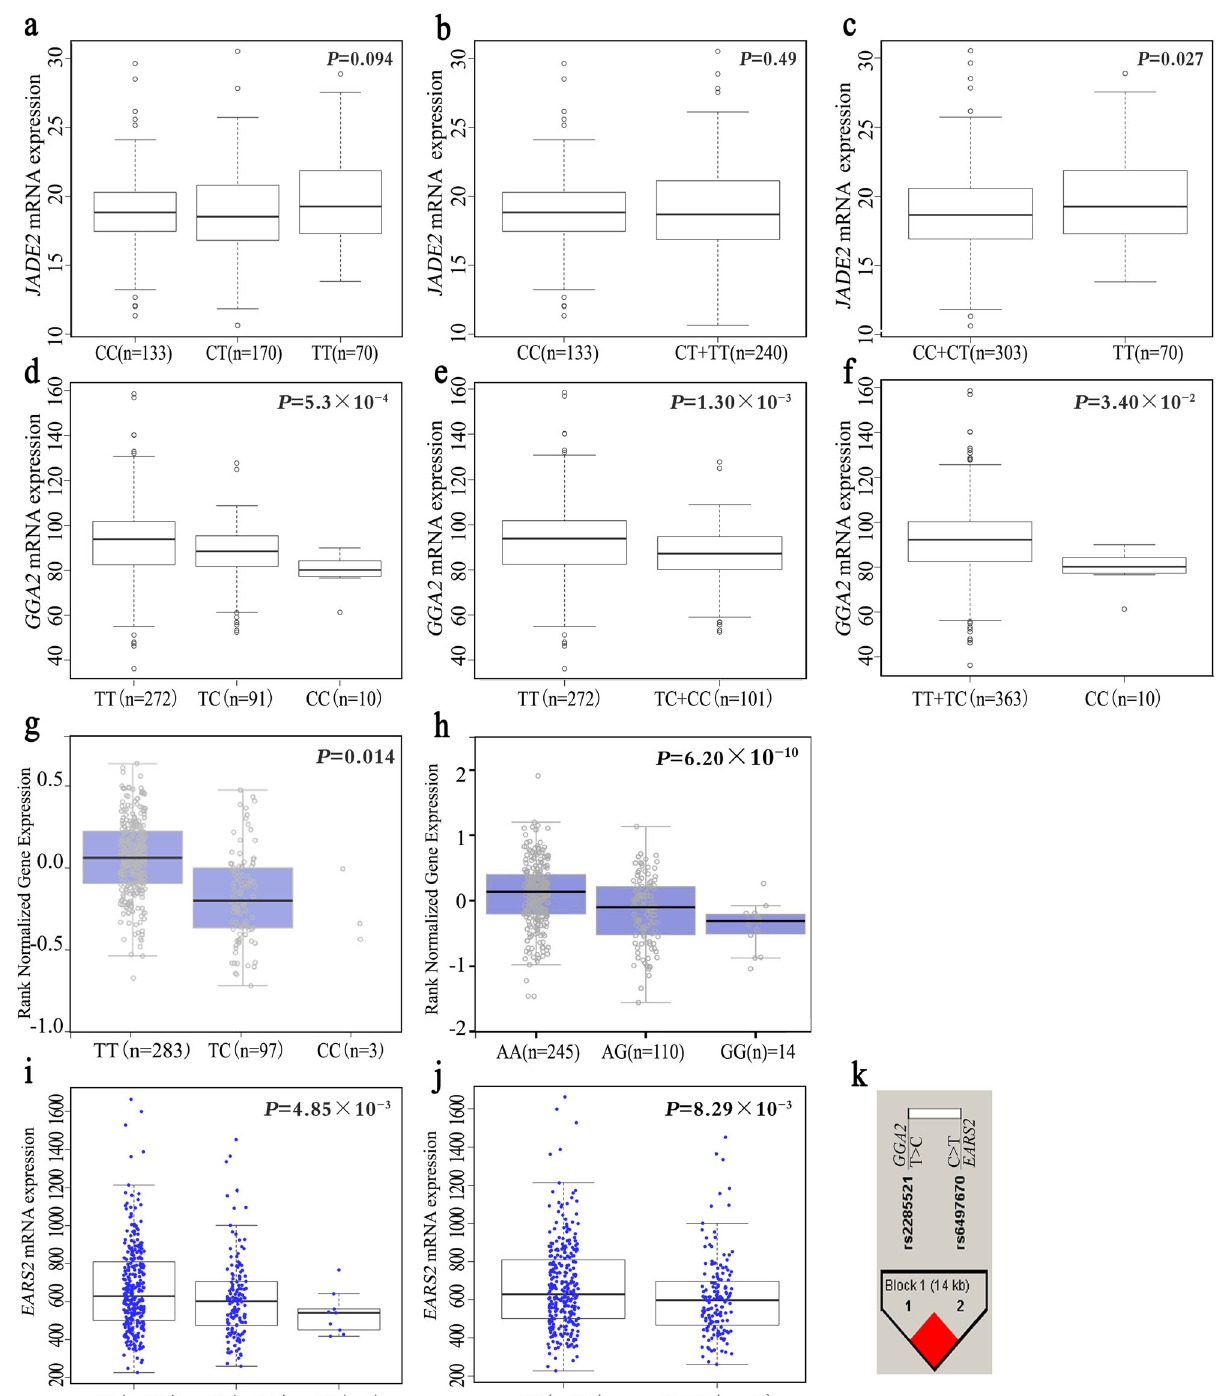
Fig. 3 Functional analyses of rs329118 on JADE2 , rs2285521 on GGA2 , and rs198459 on MYRF . Correlation between JADE2 rs329118 and JADE2 mRNA expression levels in additive ( a ), dominant ( b ), and recessive ( c ) models in 373 blood cells from 373 Europeans individuals in 1000 genomes project ( P = 0.094, 0.487 and 0.027, respectively). Correlation between GGA2 rs2285521 and GGA2 mRNA expression levels in additive ( d ), dominant ( e ), and recessive ( f ) models in 373 blood cells from 373 Europeans individuals in 1000 genomes project ( P = 5.30 × 10 − 4 , 0.0013 and 0.034, respectively). Correlation between GGA2 rs2285521 ( g ) and MYRF rs198459 ( h ) , and mRNA expression levels in normal lung tissues or whole blood cells of GTEx project ( P = 0.014 and P = 6.20 × 10 − 10 , respectively). i , j Correlation between EARS2 rs6497670 in additive ( i ) and dominant ( j ) models in lung cancer tissues of TCGA project ( P = 4.85 × 10 − 3 and P = 8.29 × 10 − 3 , respectively). k Pair-wise LD plot between GGA2 rs2285521 (T>C) and EARS2 rs6497670 (C>T). a – j P value was calculated from linear regression. Center-line indicates the median expression level across all participants in that group, and the hinges represent the lower (Q1) and upper (Q3) quartile, with lower whisker indicating the smallest value within 1.5 interquartile range (IQR) below Q1 and upper whisker indicating the largest value within 1.5 IQR above